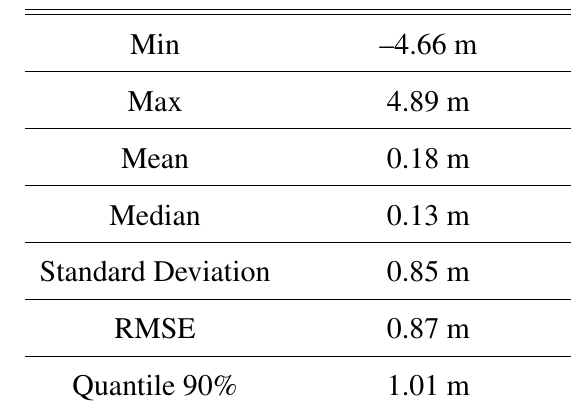
Table 1. Comparison of the ground truth against ICESat points.